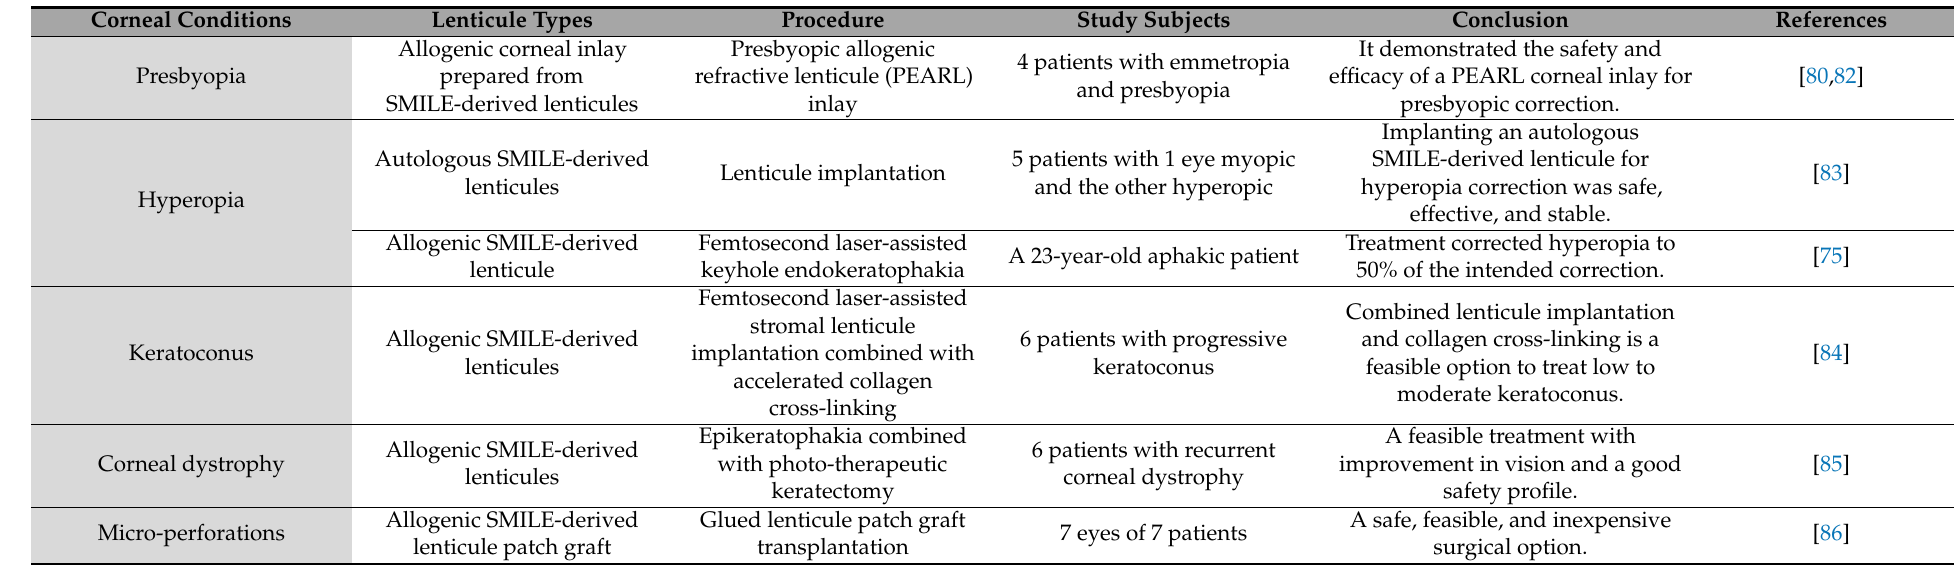
Table 1. Clinical studies of SMILE lenticule